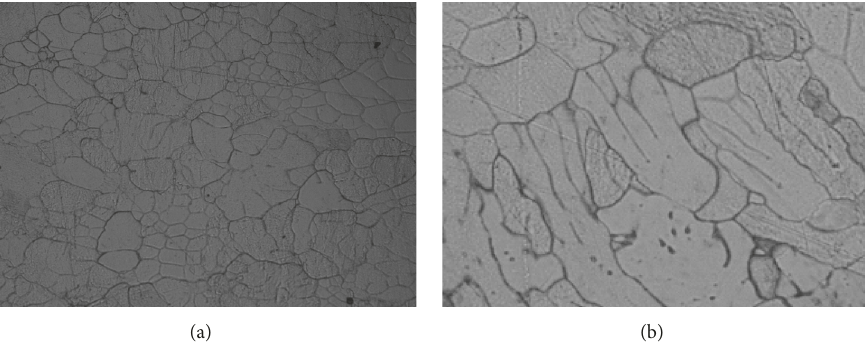
Figure 4: Solidification simulation of the cross section and lengthwise section of twin-roll cast Al-10Mg alloy wedge-shaped plate: (a) rolled plane; (b) longitudinal section.